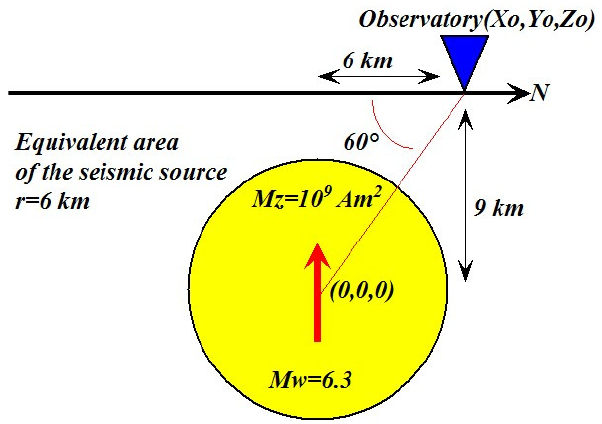
Fig.9 Simple model of magnetic source generating the observed signals. Fig. 9. Simple model of magnetic source generating the observed signals.